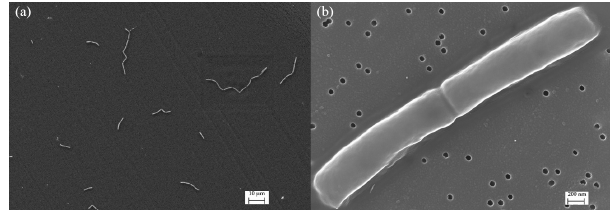
10 6 CFU mL − 1 , the initial cells suspension with an OD 600nm around 0.6 (single values are reported in Table 4) was diluted (1 : 10, 1 : 15, 1 : 20, 1 : 40) before the injection, to avoid